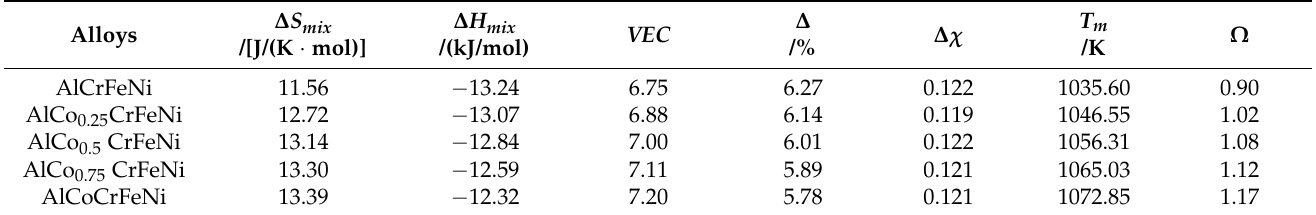
Table 1. The mixed entropy ∆ S mix , mixed enthalpy ∆ H mix , valence electron concentration VEC , atomic radius difference δ , electronegativity difference ∆ χ , melting point T m and parameter Ω of